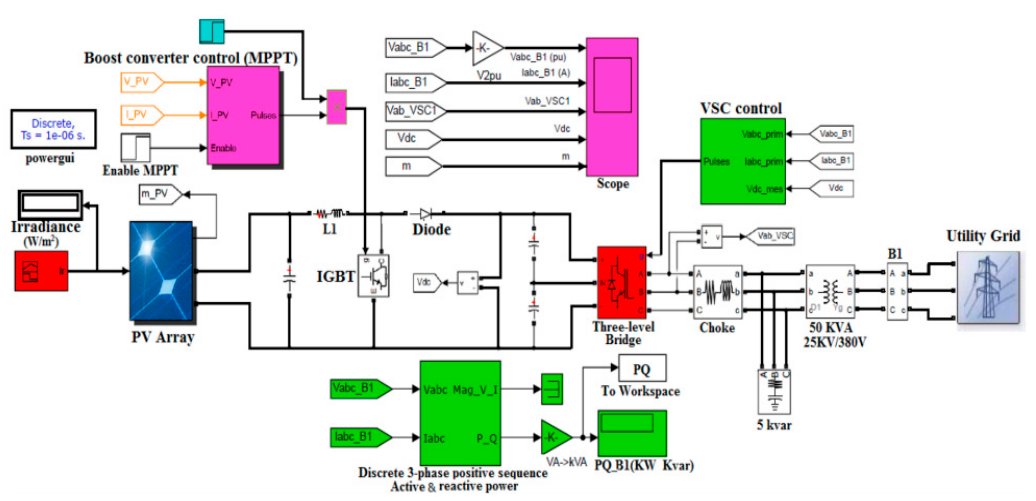
Figure 18. PV-Grid connected system Simulation in Matlab.